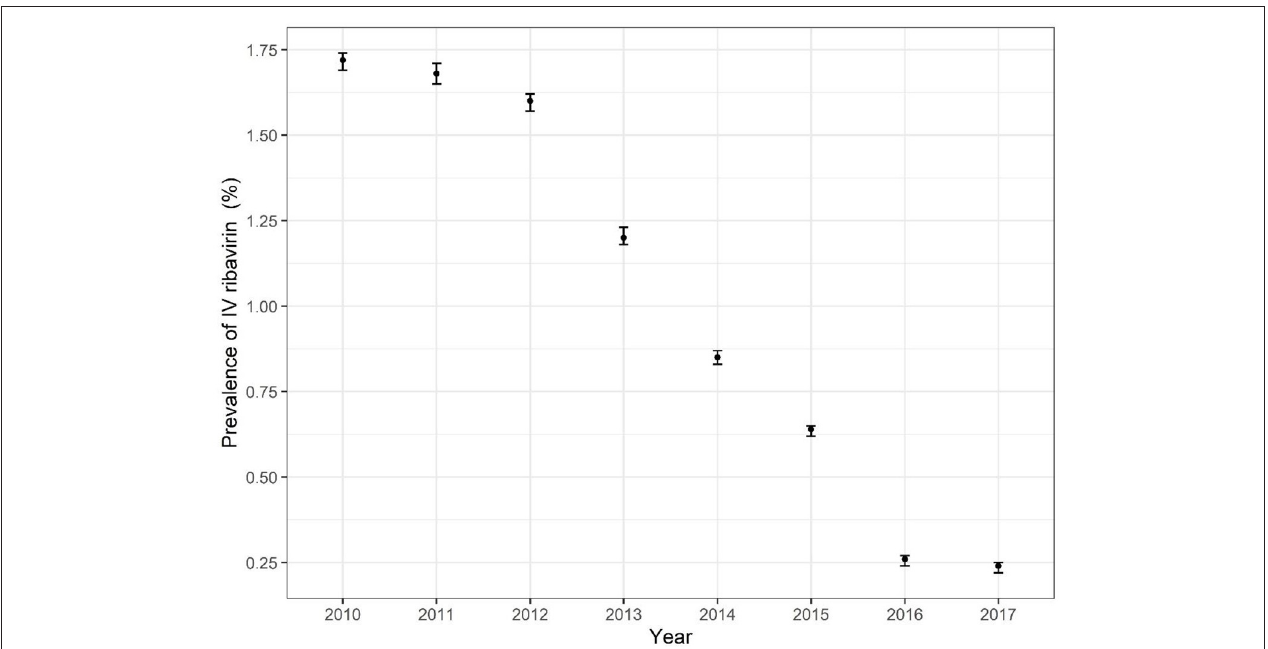
FIGURE 2 | Prevalence of Use of IV ribavirin by Calendar Year among general population in reproductive age.